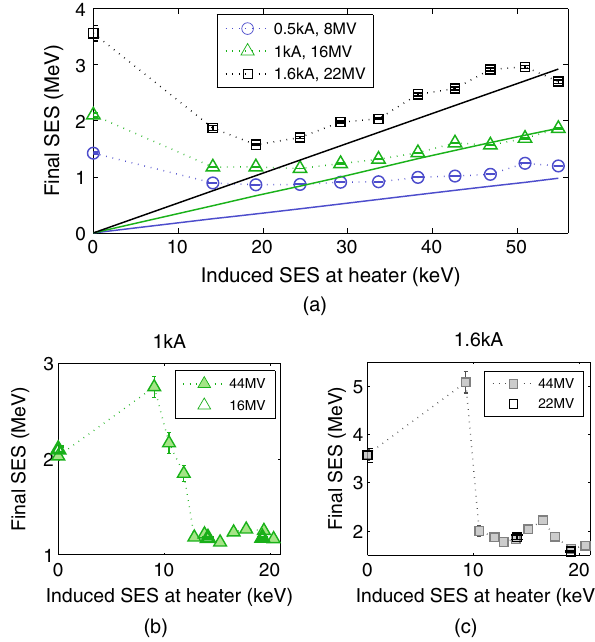
FIG. 9. (a) Final rms SES as a function of induced SES from the laser heater. Solid lines show the expected energy spread from phase space compression, assuming an initial current of 28 A. Below, finer scans at lower heater settings for peak currents of 1 kA (filled triangles, (b) and 1.6 kA (filled squares, (c) overlaid with corresponding data from (a). In both cases a low level of heating actually increases energy spread compared to heater off. We ignore the beam ’ s initial SES, which is negligible compared to that induced by the laser heater and MBI. In all plots “ MV ” refers to XTCAV voltage.